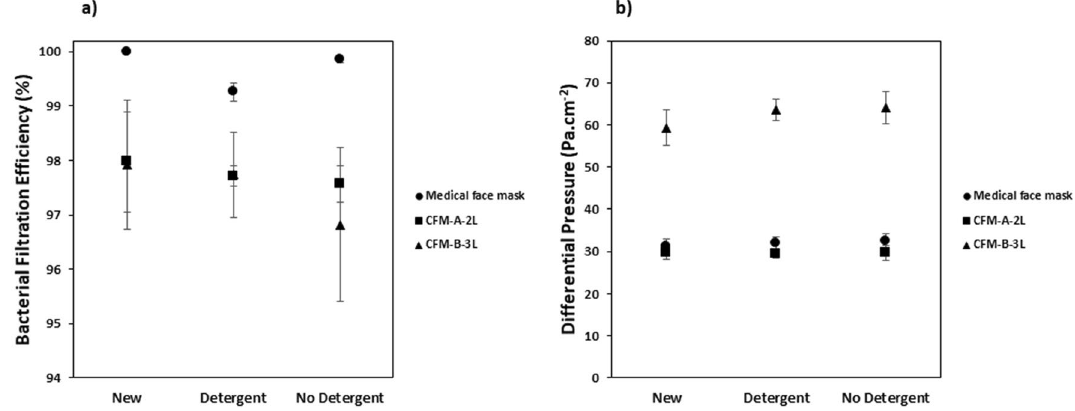
Figure 7. Influence of detergent on ( a ) Bacterial Filtration Efficiency (%) and ( b ) Differential Pressure (Pa cm −2 ) for the medical face mask and the community face masks. Average values (N = 5) ± standard-deviation.